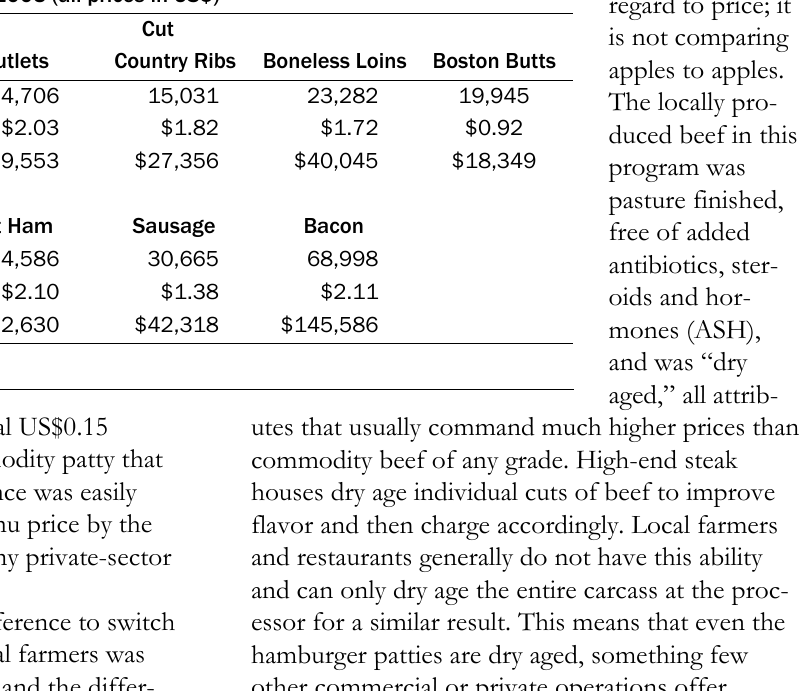
Table 2. KY State Parks Pork Usage, 2005 (all prices in